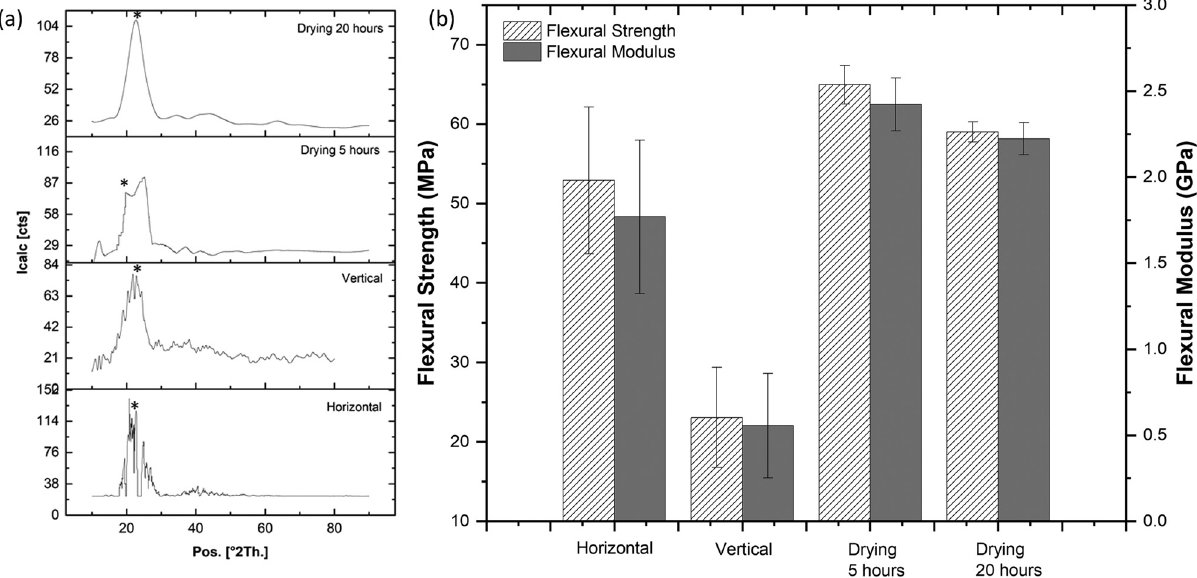
Figure 3: ( a ) XRD crystallography of PACF sample printed in various directions and drying for various hours and ( b ) fl exural bending test on PACF